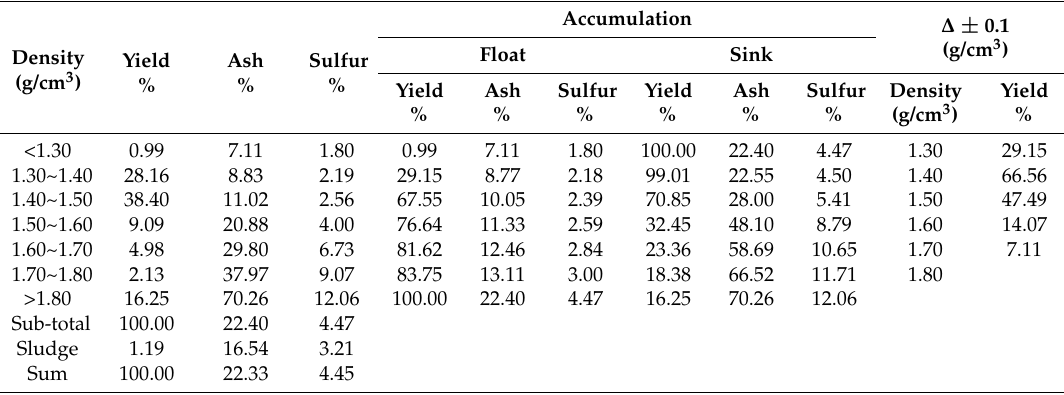
Table 2. Float-sink test of the coal sample sieved from Hongfa natural-sized coal.